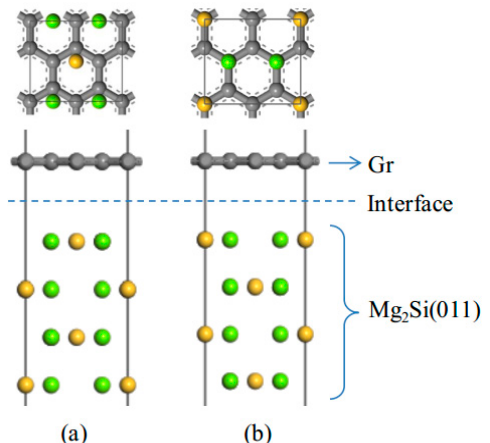
Figure 6. Interfacial atom stacking site and interfacial model of Mg 2 Si (011)/Gr (0001) interface: ( a ) Si-center-sited; ( b ) Mg-center-sited (the green ball represents Mg atom, the yellow ball represents Si atom, the gray ball represents C atom).